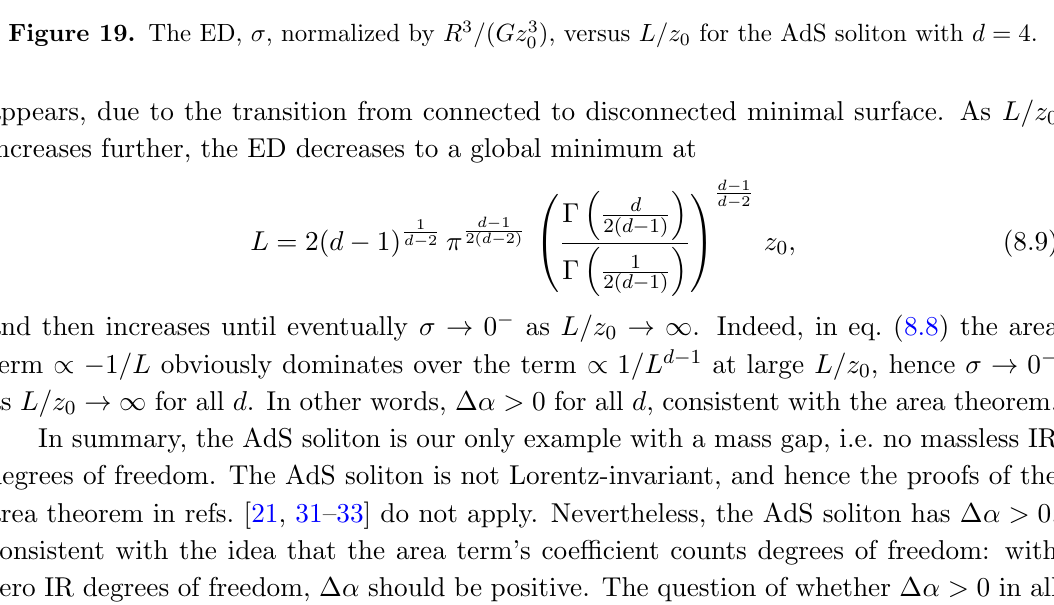
Figure 19. The ED, (cid:27) , normalized by R 3 = ( Gz 3